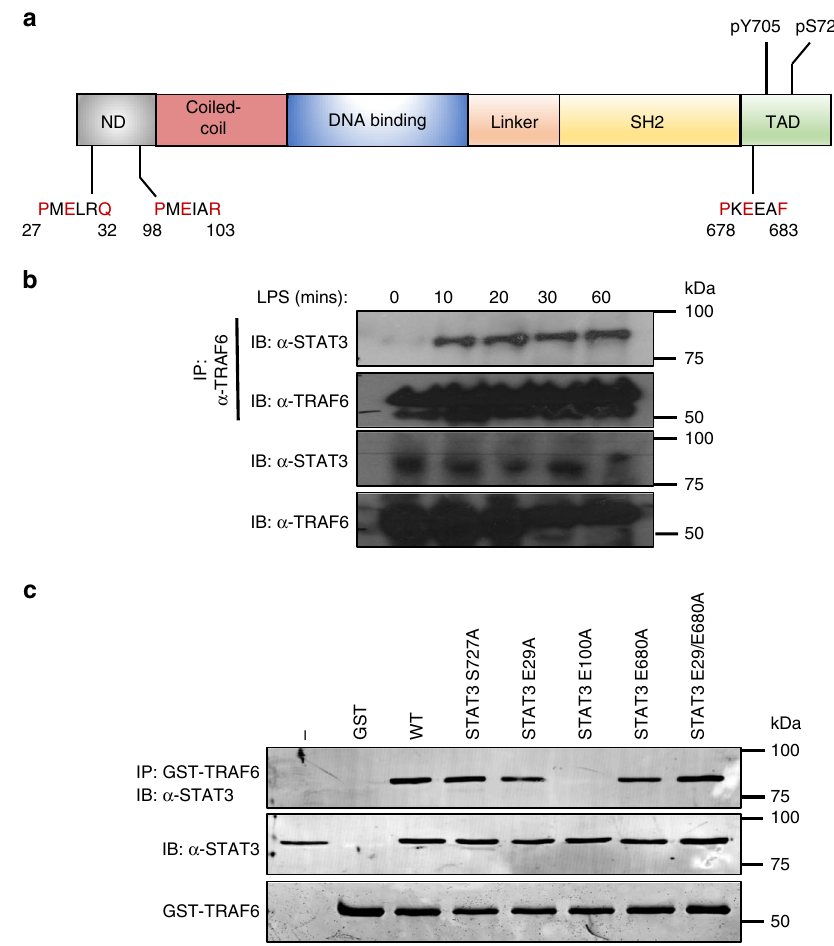
Fig. 1 STAT3 directly interacts with TRAF6 after LPS stimulation. a Schematic representation of the putative TRAF6-binding domains and phosphorylation sites of STAT3. ND: N-terminal domain: SH2: Src homology domain TAD: transactivation domain. b BMDMs (1 × 10 7 cells) were seeded in 10 cm culture dishes and grown for 24 h prior to stimulation with LPS (1 μ g/ml) for indicated times. TRAF6 was immunoprecipitated from cellular lysates and probed with anti-TRAF6, or STAT3 antibody ( n = 3) c HEK293T cells (1 × 10 6 ) were transfected with indicated plasmid vectors for 24 h. Cells were lysed and probed with recombinant GST-TRAF6 to immunoprecipitated interacting proteins, separated by SDS-PAGE and probed with anti-FLAG antibody ( n =